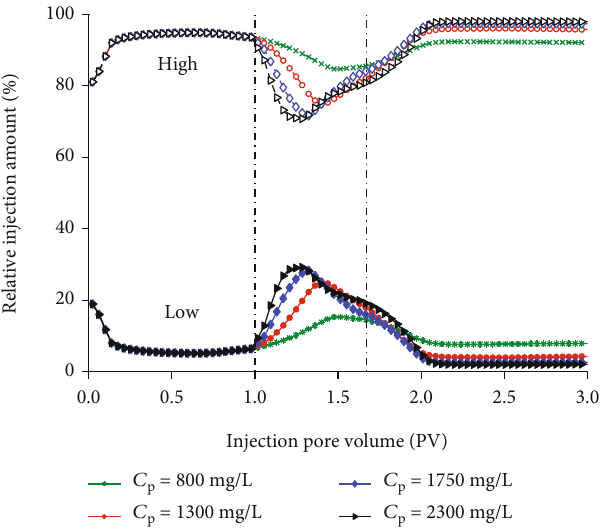
Figure 10: Injection conformance behavior for reservoirs with di ff erent polymer